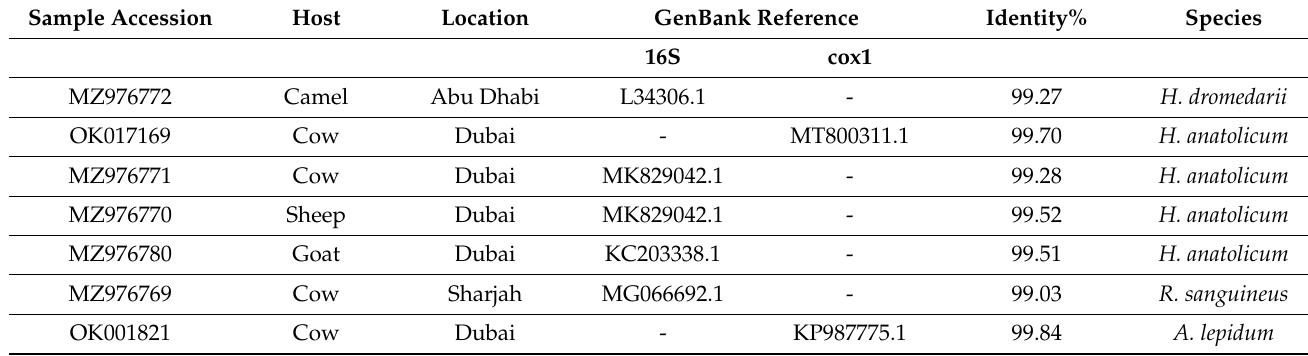
Figure 2. Hyalomma dromedarii male from the United Arab Emirates: ( i ) dorsal view: (a) central festoon, (b) cervical and lateral grooves, (c) marginal grooves, (d) paramedian grooves, (e) posterome- dian groove, (f) cervical grooves, (g) basis capituli; ( ii ) ventral view: (h) sub-anal plates, (i) spiracular plates, (j) posterolateral spurs, (k) posteromedian spur [11,32]. Hyalomma anatolicum ticks were small in size (about 2.69 mm in length), oval in shape, Table 2. Identity of tick species and percentage similarity value with the reference sequences from the